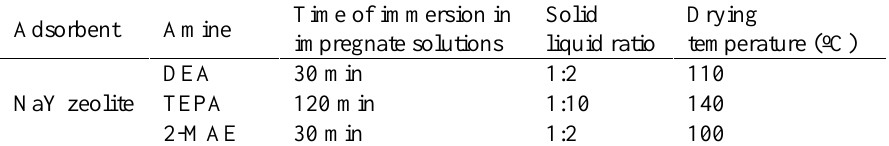
Table1. Summary of amine impregnation conditions on Nay zeolite